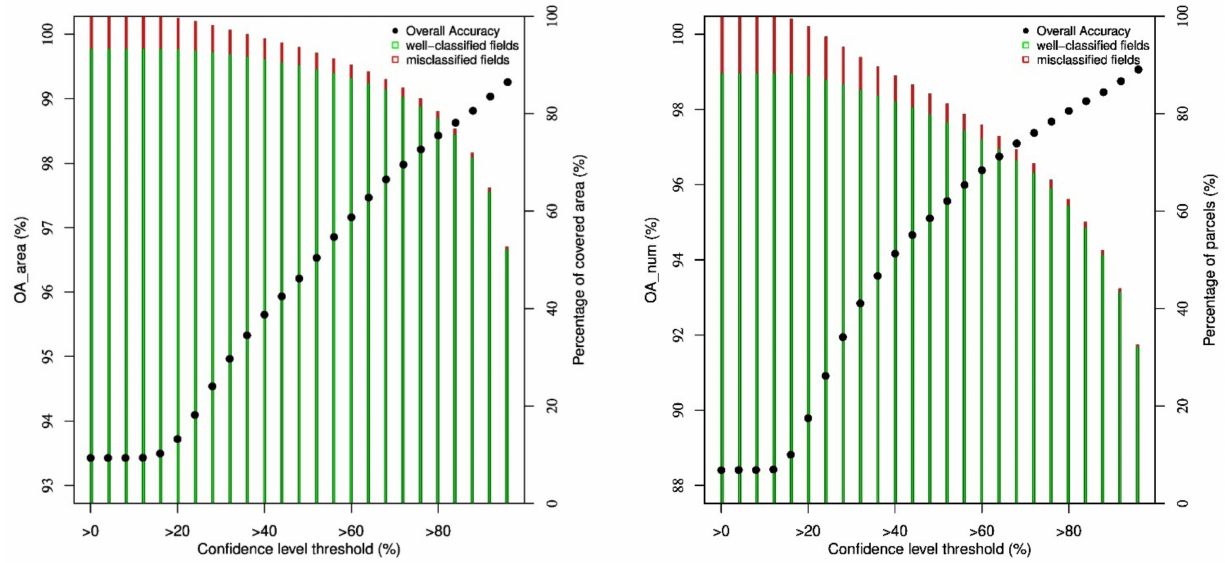
Figure 3. Evolution of the overall accuracy considering only the parcels in the validation dataset whose confidence level is above a given threshold (for scenario 1). ( Left ): OA in terms of the area. ( Right ): OA in terms of the number of